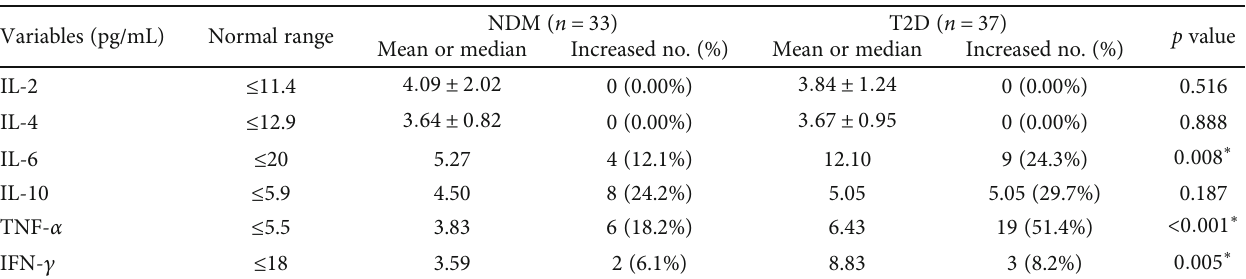
Table 5: Serum levels of Th1/Th2 cytokines in patients with and without type 2 diabetes.